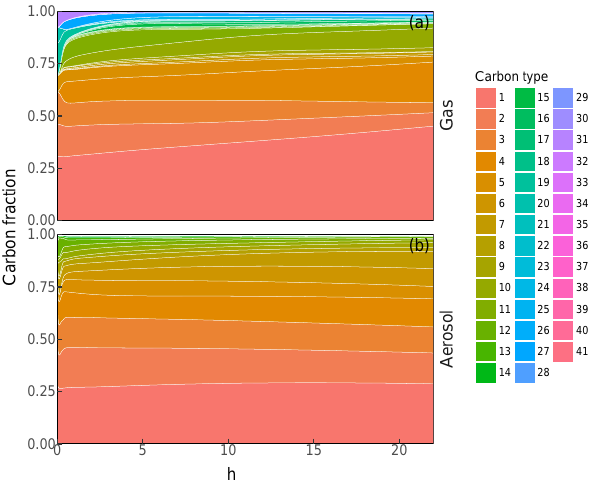
Figure 3. Time series of carbon type abundances for the APIN sim- ulation described in Sect. 2.1. The carbon types are defined in Fig. 2.